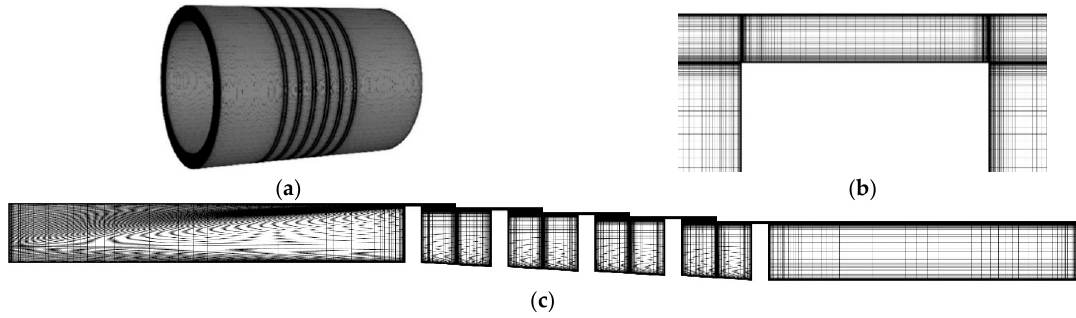
Figure 2. Computational domain of the straight ‐ through seal. ( a ) Whole shape of the grids. ( b ) Enlarged part of the grids. ( c ) Computational domain of the stepped labyrinth seal. Analyses were performed to confirm the sensitivity to the number of grids in two dimensions. From approximately 64,000 to 700,000 grids, alignment grids were created using ANSYS ICEM. In addition, ANSYS Fluent v20.1 was used as the solver. Figure 3 shows that 100,000 and 230,000 grids indicated a 0.1% difference in the discharge coeffi ‐ cient, and approximately 230,000 and 700,000 grids indicated a 0.2% difference. Although no feasibility problems occurred even when the analysis was performed on 100,000 grids, approximately 230,000 grids were used to sufficiently express the flow field. Figure 3. Grid test using the discharge coefficient. Table 1 lists the length of each shape of the labyrinth seal. Because the labyrinth seal has a limited axial length, the straight labyrinth seal was adjusted to contain six teeth and the stepped labyrinth seal to have a five ‐ tooth structure. The shape variables in this study were analyzed by selecting CW, SH, and SP. CW* and SH* were normalized to clearance, and SP* was normalized to the cavity width. Table 1. Geometrical parameters of the labyrinth seals. Geometry Parameter Straight ‐ Through Seal [16]